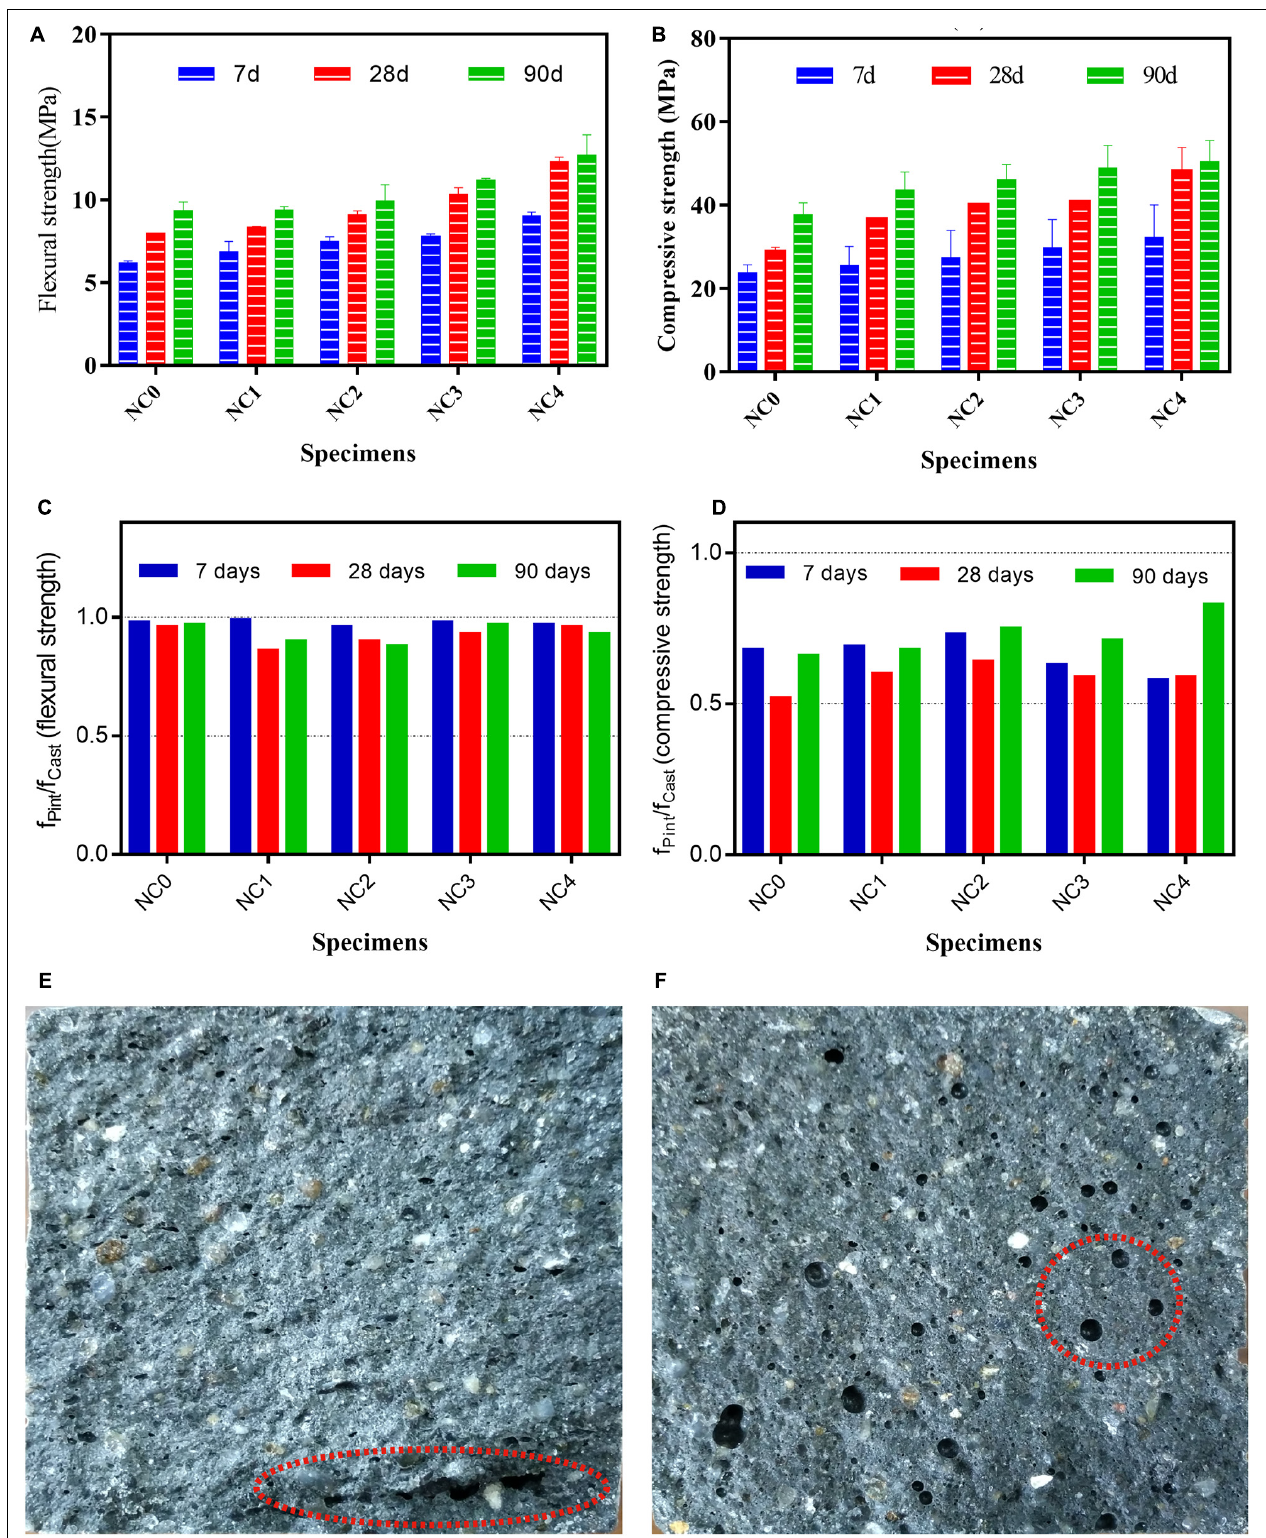
FIGURE 11 | (A) Flexural strength, (B) compressive strength, (C) flexural strength ratio between 3DPC and cast concrete, (D) compressive strength ratio between 3DPC and mold cast samples, (E) typical section of 3D printing prismatic specimen, (F) typical section of mold cast prismatic specimen.